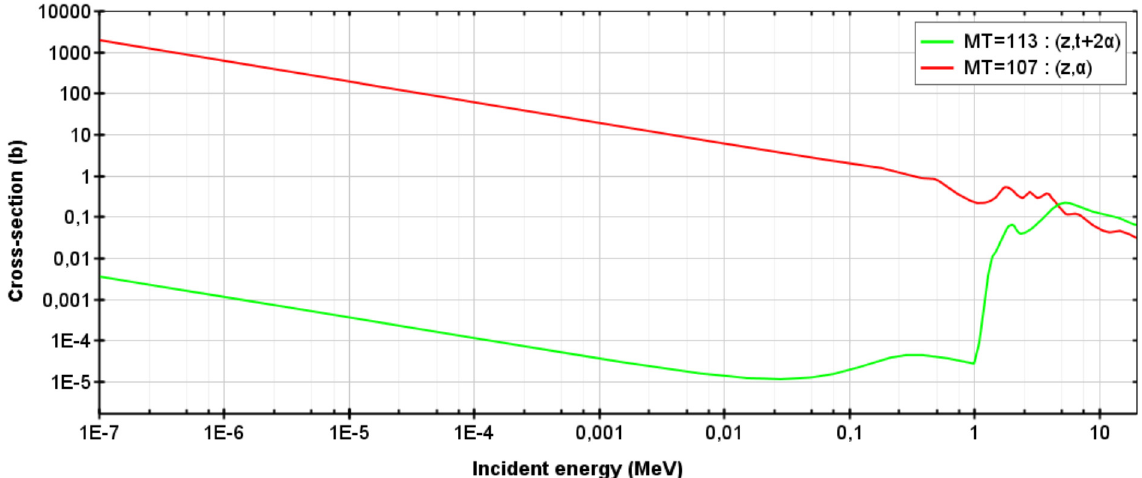
Fig. A3. Cross sections of the production of alpha and tritium particles on boron